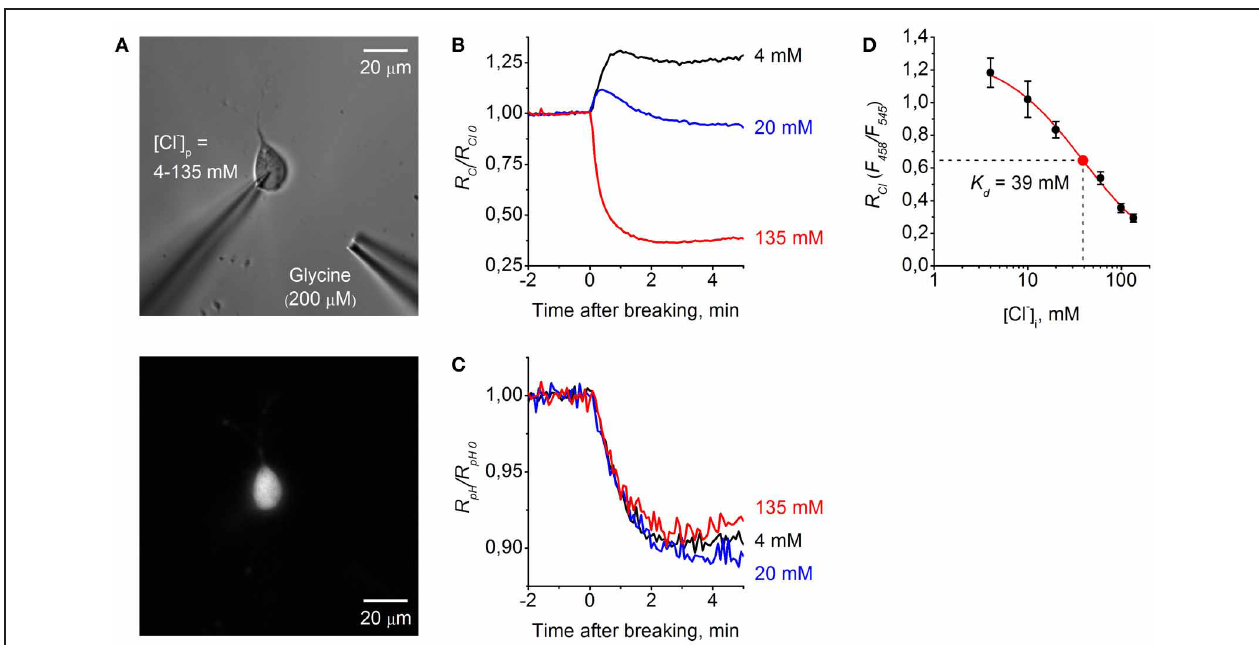
corresponds to the moment the membrane breaks to give whole-cell mode. (C) Relative changes in R pH ( F 488 / F 458 ) recorded simultaneously in the same cells as in (B) before and after cells transition into the whole-cell configuration. (D) Calibration curve for ClopHensor obtained by recording of R Cl at six different [Cl − ] p : 4, 10, 20, 60, 100, and 135mM. K d = 38 . 9 ± 6 . 5mM (mean ± s.e.m.). Data from 5–7 cells for each [Cl − ] p are presented. Note the approximately four-fold change in R Cl when[Cl − ] i isadjusted